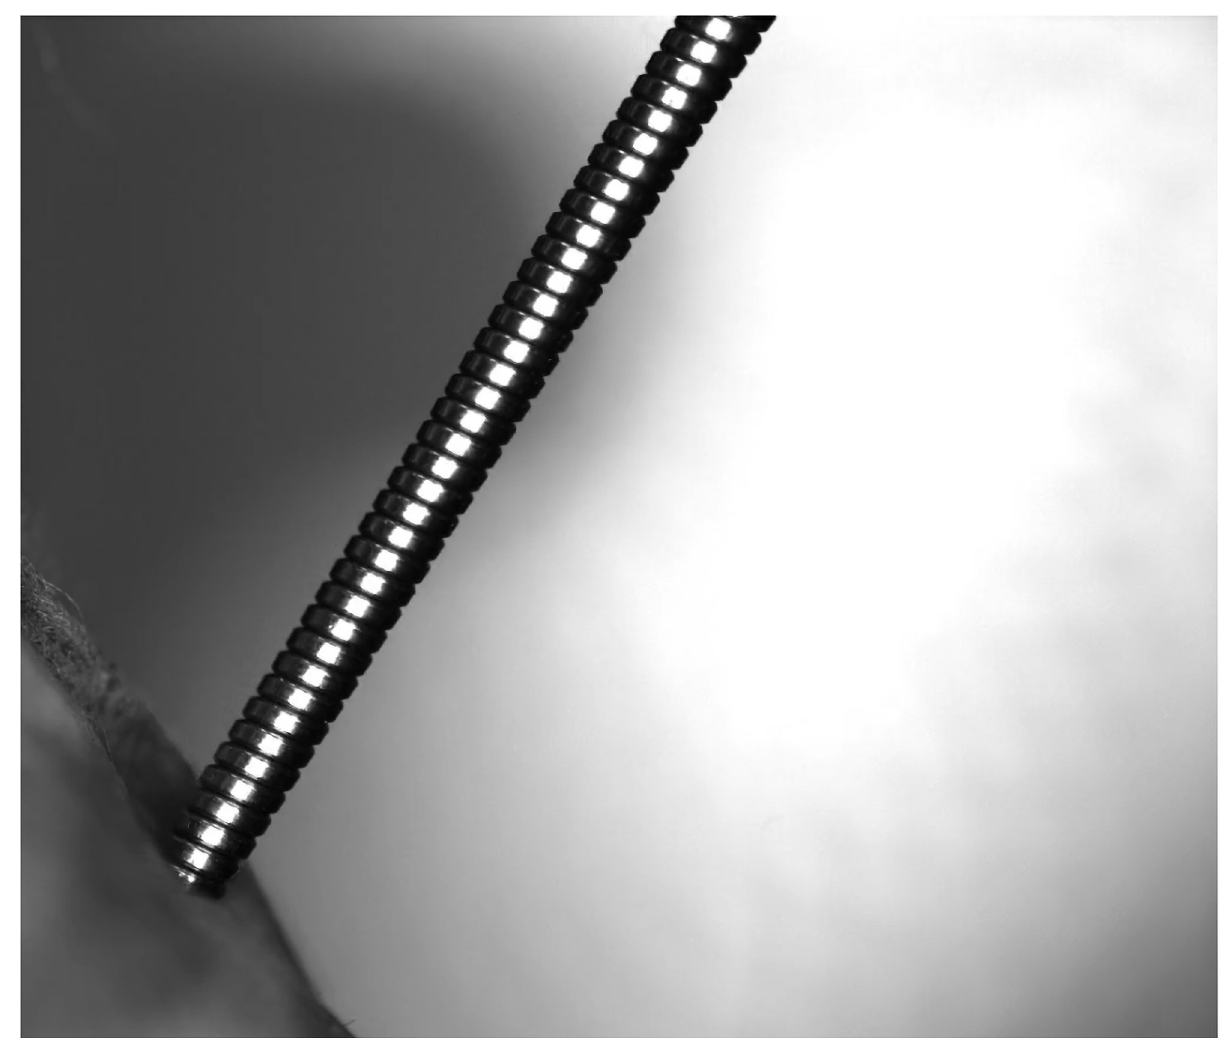
Fig 4. No release of fluid particles from the working channel of the endoscope. The picture shows that no water droplets are generated or released from the working channel thanks to the protective cover on the endoscope control body made out of a surgical